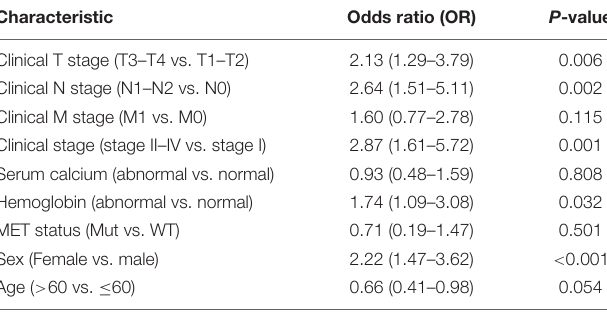
TABLE 2 | Logistic regression analysis of association between clinicopathological characteristics and TICRR expression in PRCC patients. Characteristic Odds ratio (OR)